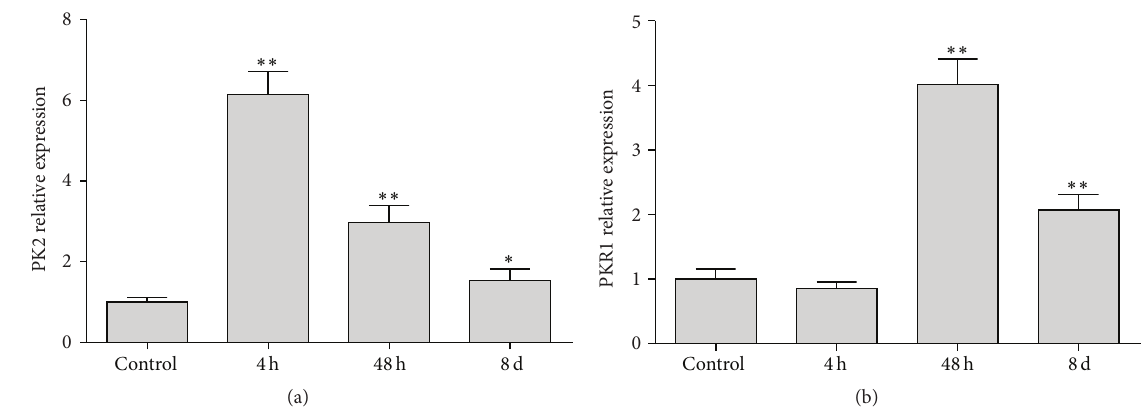
Figure 1: Time-dependent changes of PK2 and PKR1 expression in whole urinary bladders following CYP treatment with varying duration. (a) PK2 mRNA levels were significantly increased at all time points after CYP administration, compared with the controls. (b) PKR1 mRNA levels at 48 h and 8 d time points increased significantly, compared with those of the controls and 4 h time points. ∗∗ indicates 𝑃 < 0.01 ; ∗ indicates 𝑃 < 0.05 . 𝑛 = 6-7 for each